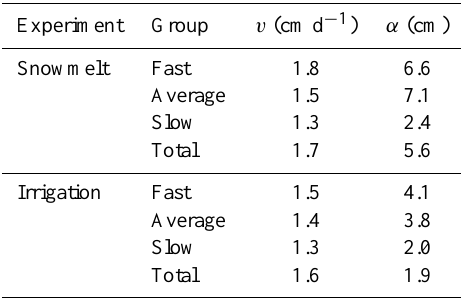
Fig. 7. The areas from the multi-compartment sampler where the highest leaching of bromide and PG occurred (based on Figs. 4 and 5).